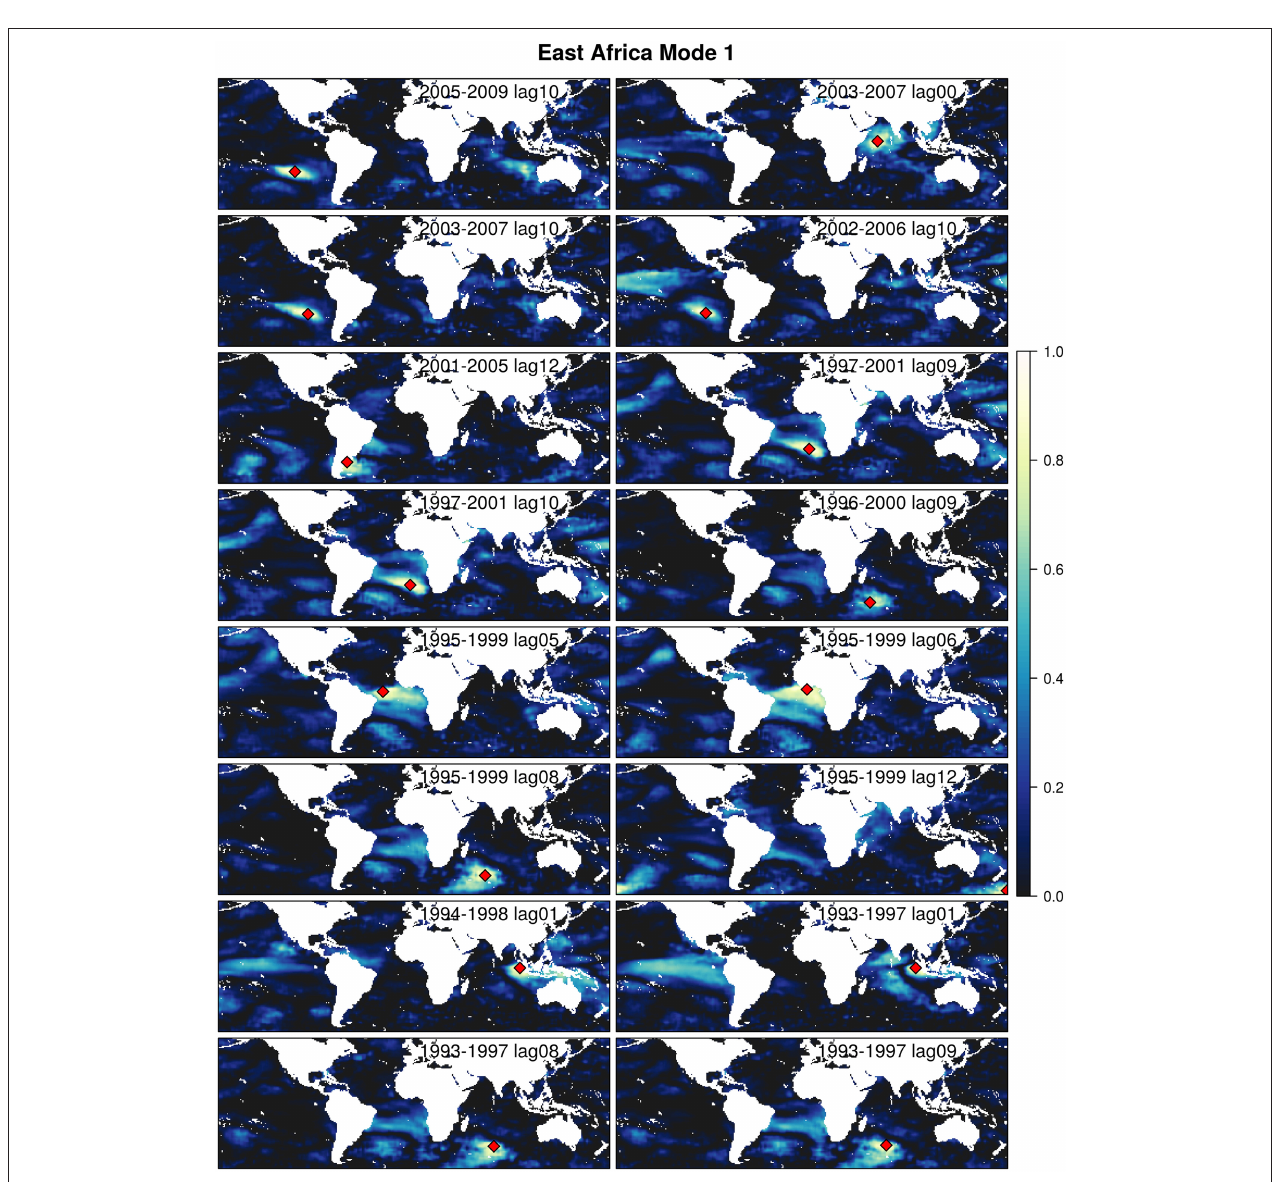
FIGURE 4 | The 16 most important patterns in mode 1 (upper 0.95 quantile in explained variance) as identified by the white squares in Figure 2.